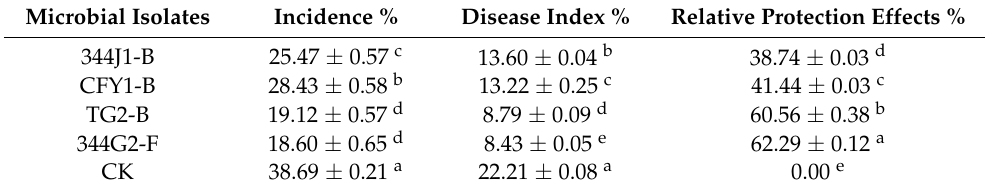
Table 4. Incidence of experimental rust in